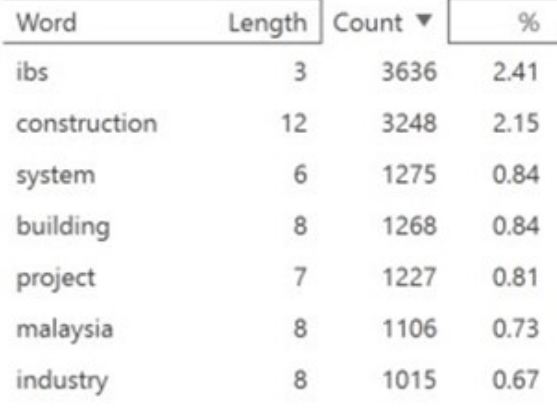
Fig. 3. Word cloud generated from 48